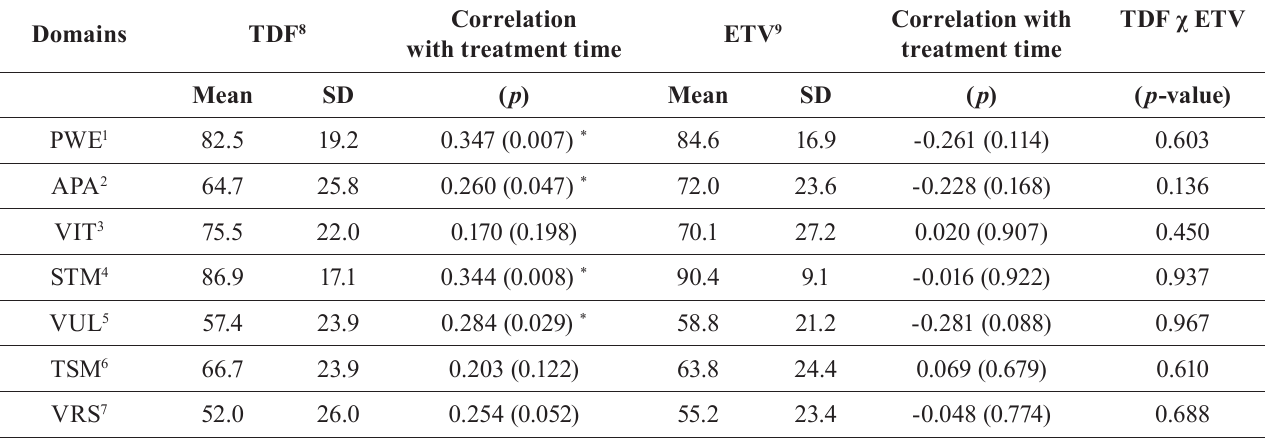
TABLE VI - Results of HRQoL domain analyzes of patients with HBC according to the use of ETV and TDF and correlation with treatment